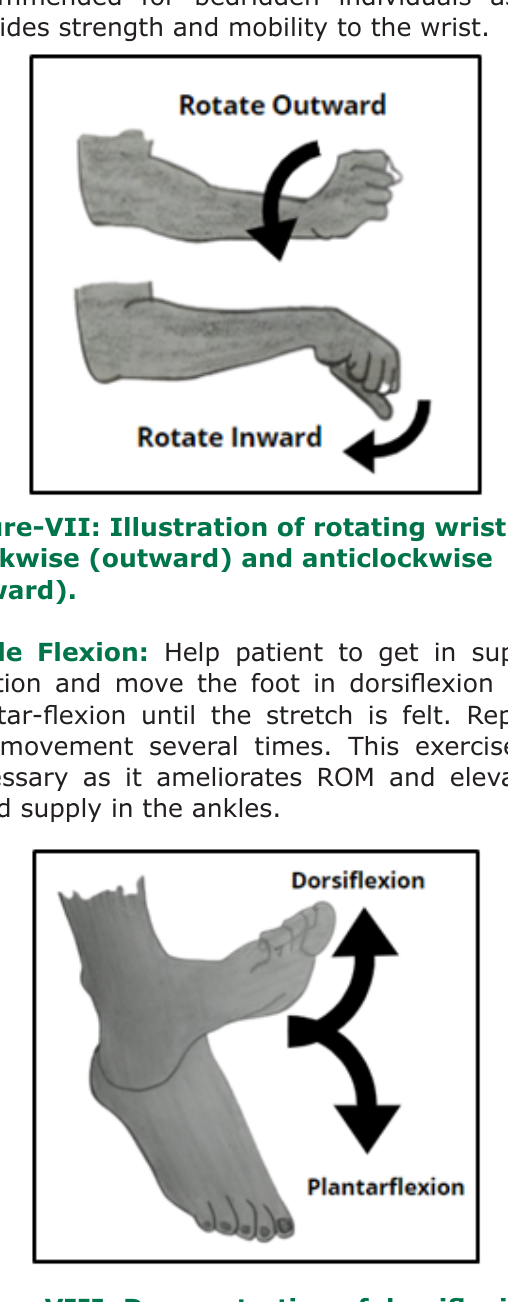
Figure-VIII: Demonstration of dorsiflexion and plantar-flexion.